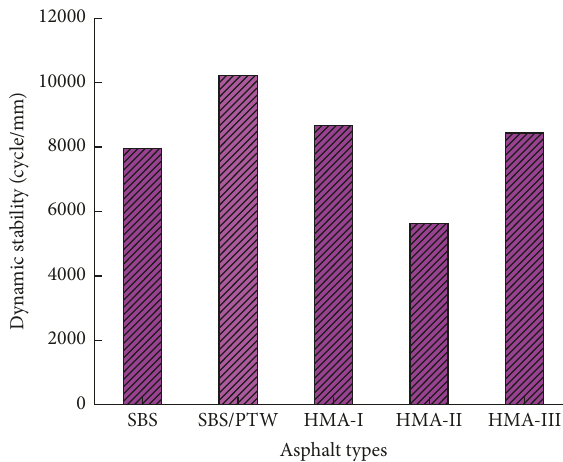
Figure 6: Dynamic stability of different mixtures.